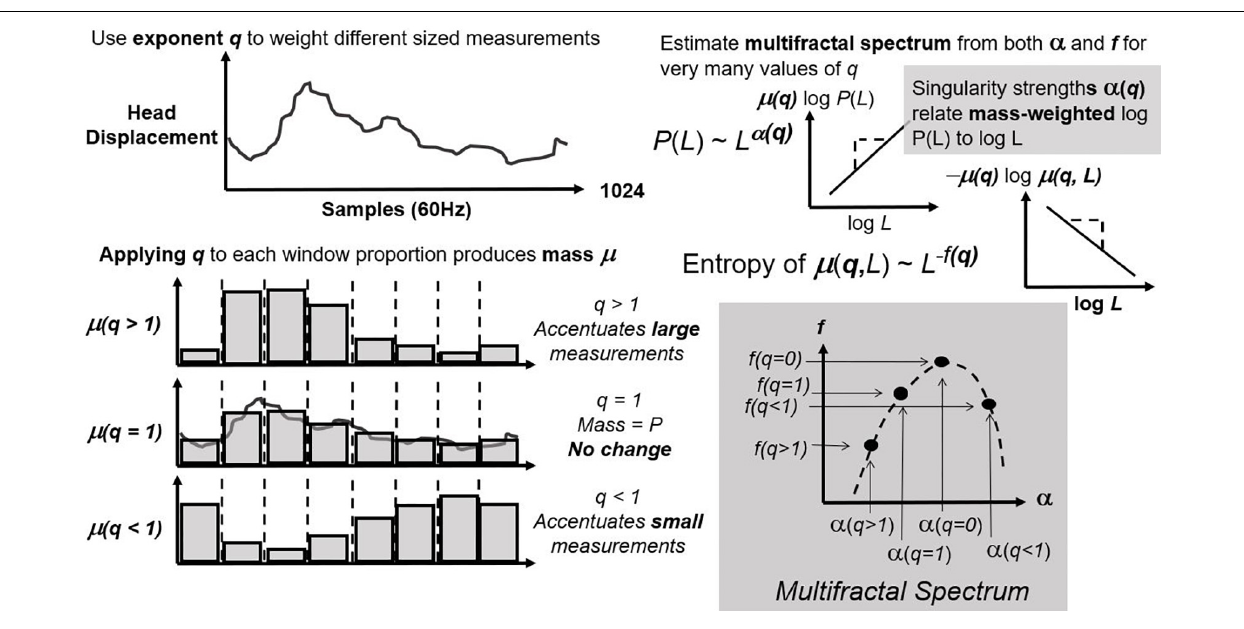
FIGURE 2 | Concluding steps of multifractal analysis that use parameter q to accentuate proportions of different size (left panel) and then re-estimate the same exponents as in Figure 1 for each new value of q (bottom panels) . The multifractal spectrum comprises ordered pairs of exponents for matching